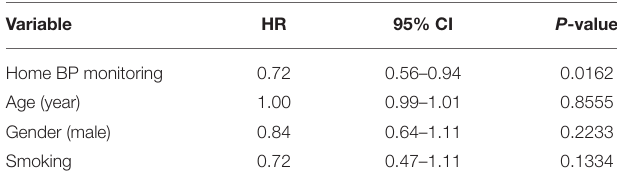
TABLE 5 | Cox regression analysis (on the stratum of BP elevation in the wintertime) for factors associated with poor outcome (eGFR decline ≥ 40%, dialysis, transplantation, or death) in 507 CKD